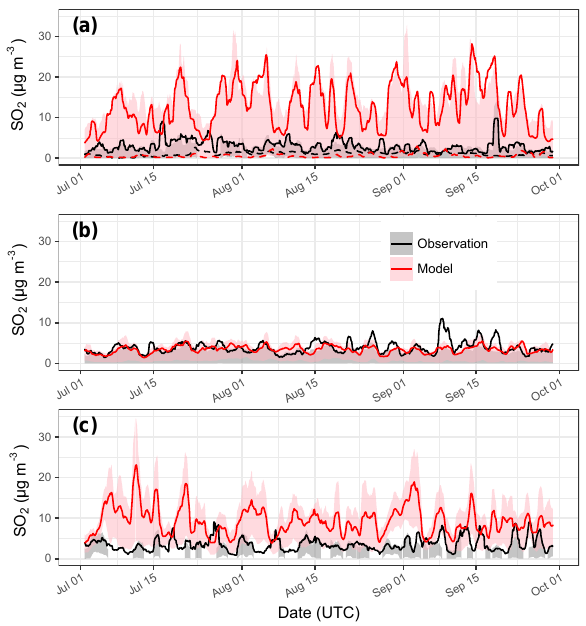
Figure 7. Same as Fig. 4 but for SO 2 . Dashed lines in (a) denote time series excluding sites in the Athabasca oil sands and northeast- ern BC oil and gas industry areas (see